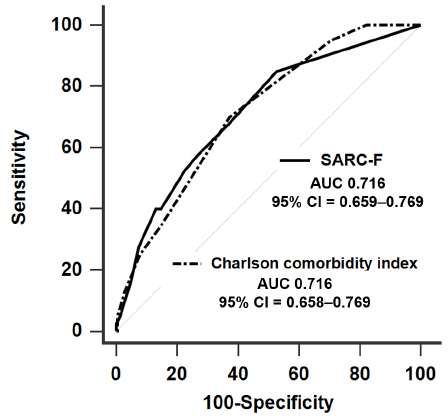
Figure 2. Receiver operating characteristic curves of SARC-F and Charlson comorbidity index on the